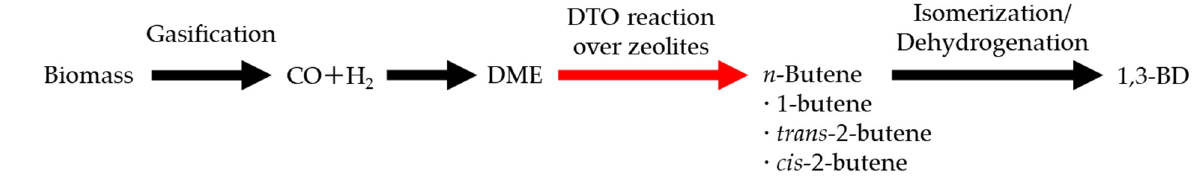
Figure 1. 1,3-Butadiene (1,3-BD) production process from biomass.